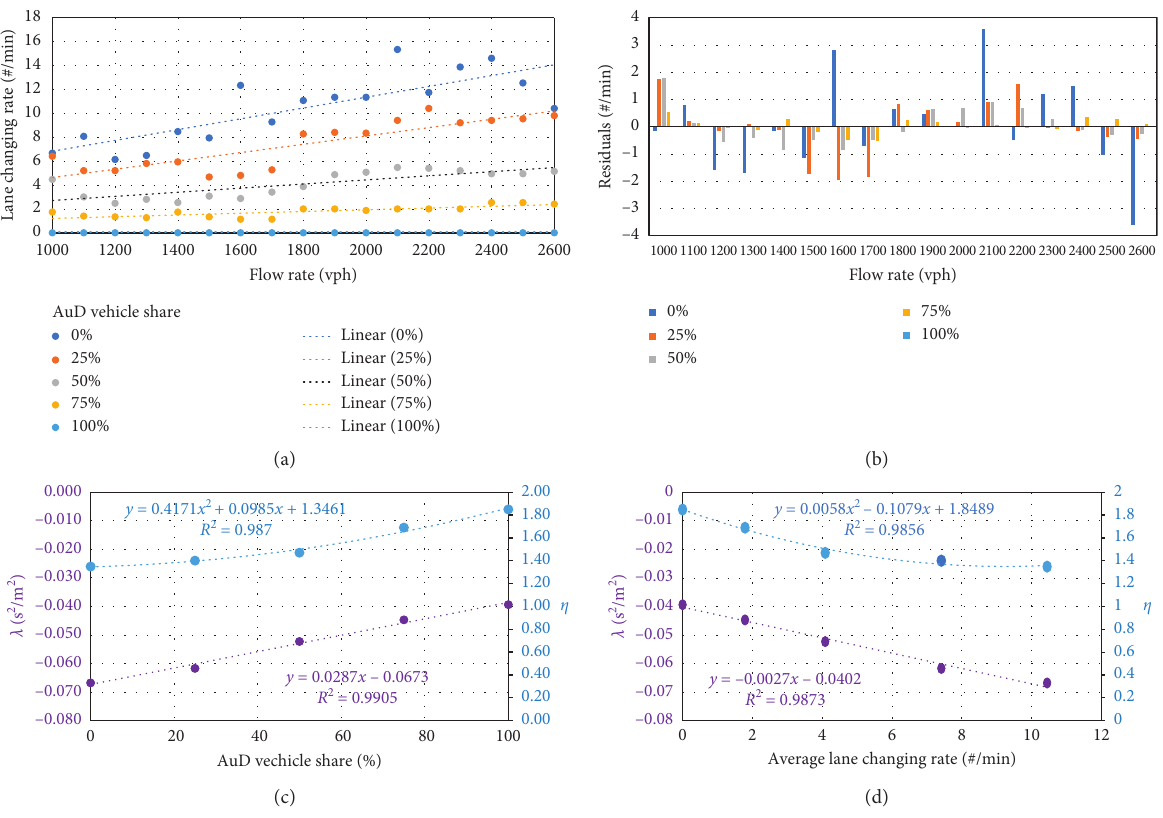
Figure 6: (a) Patterns of lane-changing rates, (b) regression residuals with increasing traffic flow rates at increasing flow rates for different mixed traffic conditions, (c) interactions of the introduced model parameters with AuD vehicle shares in traffic, and (d) average lane- changing